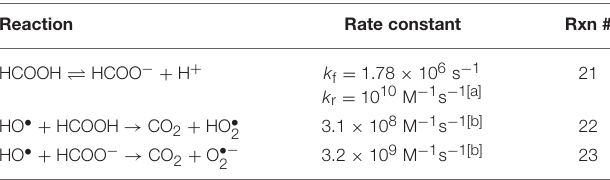
TABLE 2 | Additional reactions in the presence of formate. Reaction